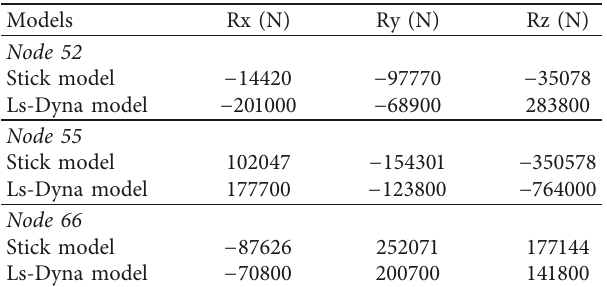
Table 6: Reaction forces achieved by the stick and 3D full-FE models during the drop